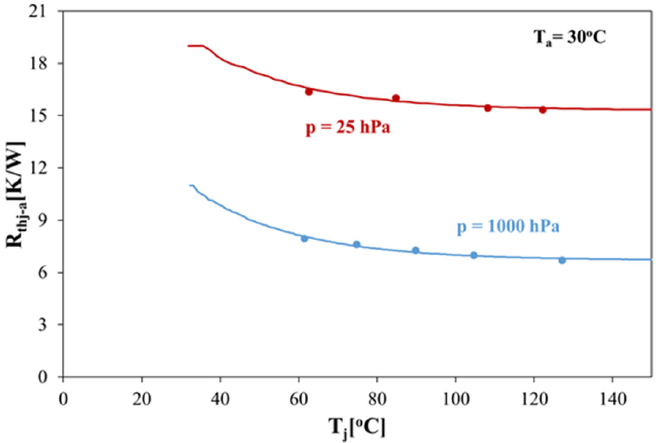
Figure 5. Measured and computed dependences of thermal resistance of the tested diode on the junction temperature for two values of atmospheric pressure .